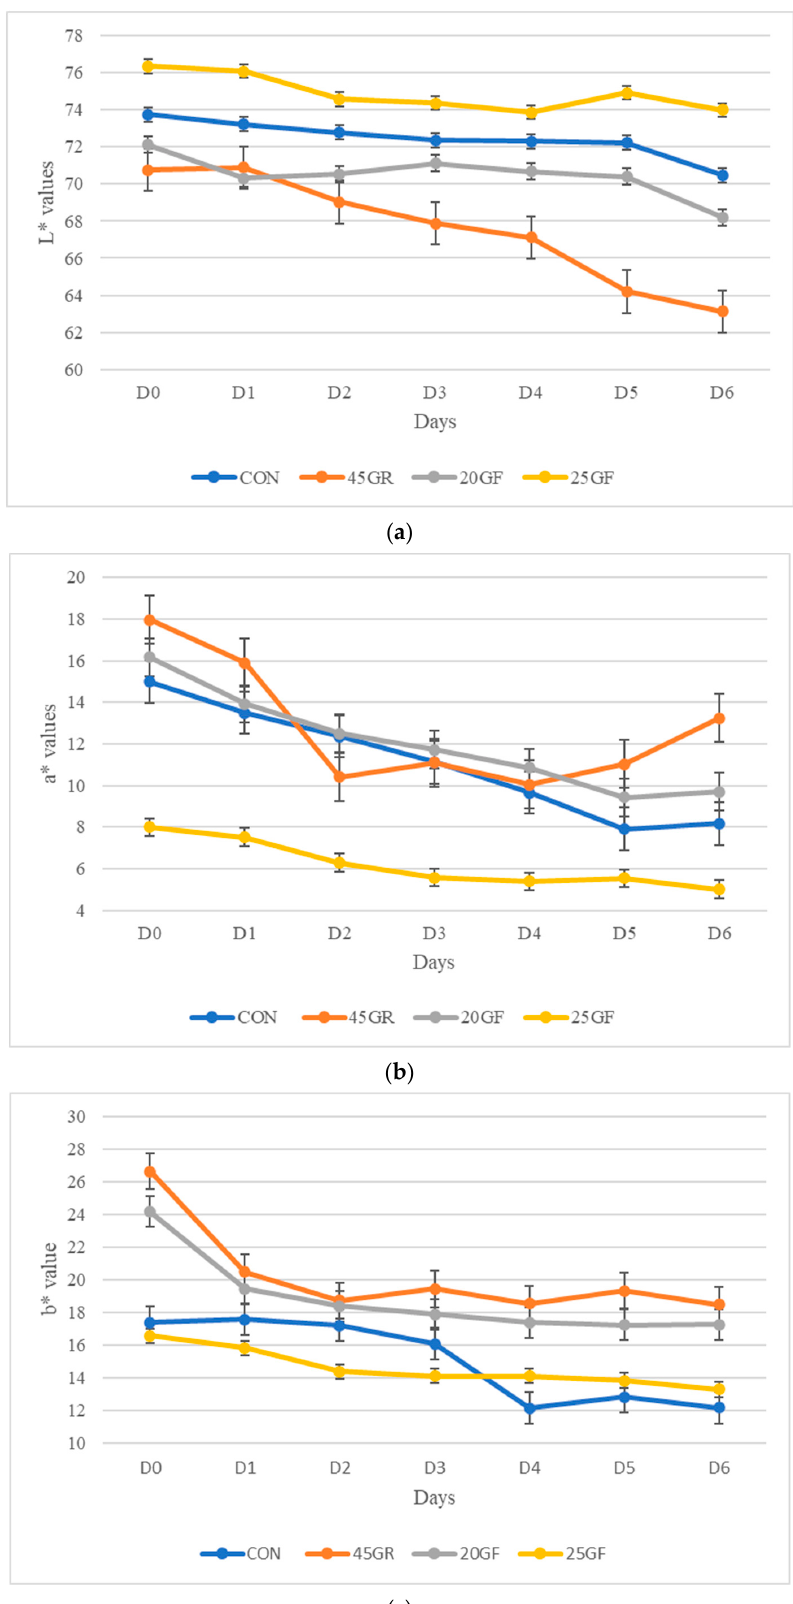
Figure 2. ( a ) Values of L* (lightness) for external fat of steaks over a six-day retail display period from conventional grain finished beef (CON), 20-months-grass-fed beef (20GF), 20-months-grass-fed